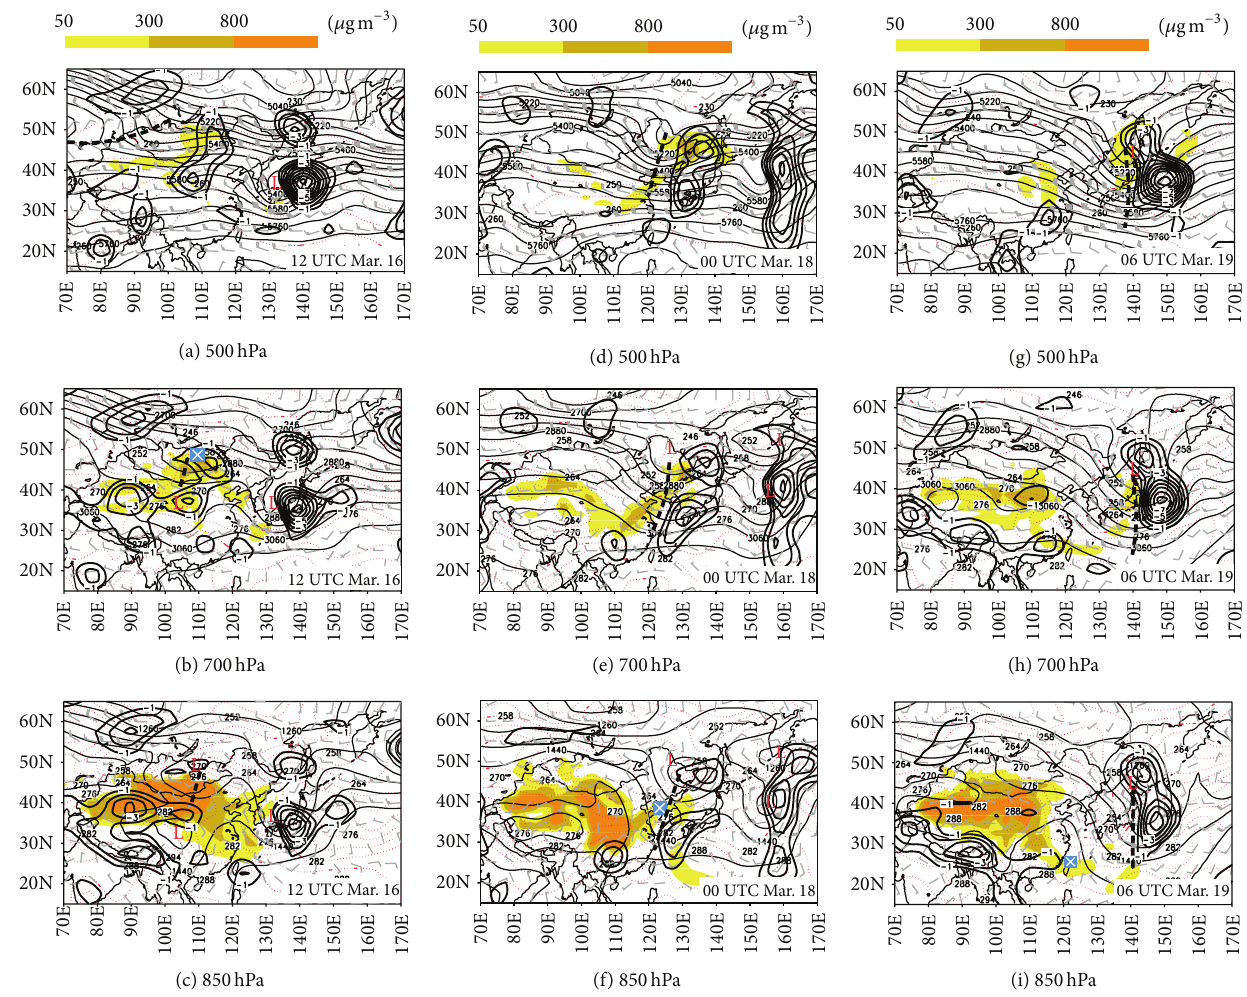
Figure 6: Synoptic maps for southeastward event at 500 hPa, 700 hPa, and 850 hPa of (a)–(c) 1200 UTC on 16 March, (d)–(f) 0000 UTC on 18 March, and (g)–(i) 0600 UTC on 19 March, respectively. The full and half barbs represent 10 and 5m s −1 , respectively. Geopotential heights (solid lines) are analyzed at 60gpm intervals. Temperatures (dot line) are analyzed at 5 ∘ C intervals at 500 hPa and 3 ∘ C intervals at others. Upward motion (heavy solid lines) is analyzed at 10Pa s −1 intervals. Dust parcels identified by trajectory model (square with x), upper-level troughs (heavy dash line), and simulated dust concentrations (shaded) are